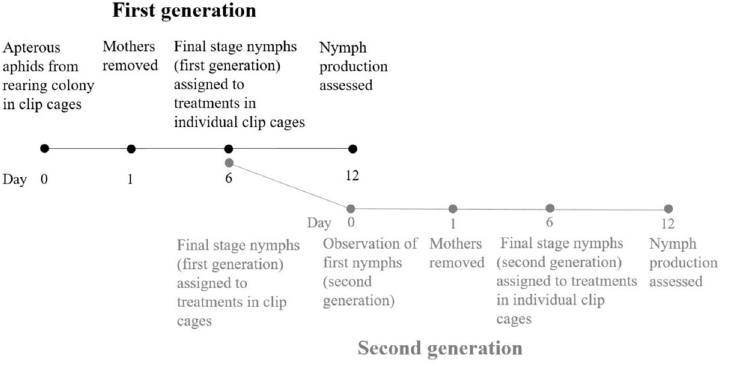
Fig 1. Diagram of the experiment showing key time